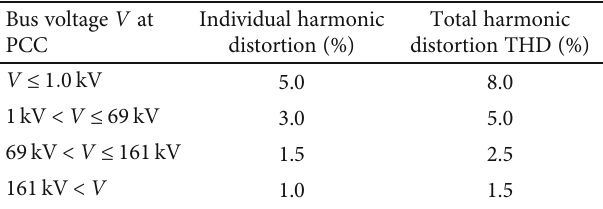
Figure 8: Single line diagram of BATA feeder with PV for harmonic analysis. Table 2: Voltage harmonic distortion